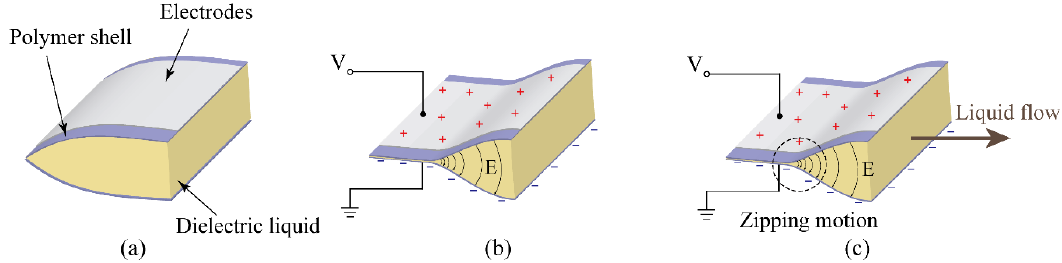
Figure 1. Illustrations of the zipping motion. ( a ) Without external voltage, the dielectric fluid transducer (DFT) is in de-activate mode, where the pouch is full of dielectric liquid. ( b ) When applying external voltages, the electrostatic forces caused by the compliant electrodes squeeze the pouch to force the dielectric liquid flow to the empty tube. ( c ) As the thickness decreases, the zipping motion occurs at the electric field concentrated area.